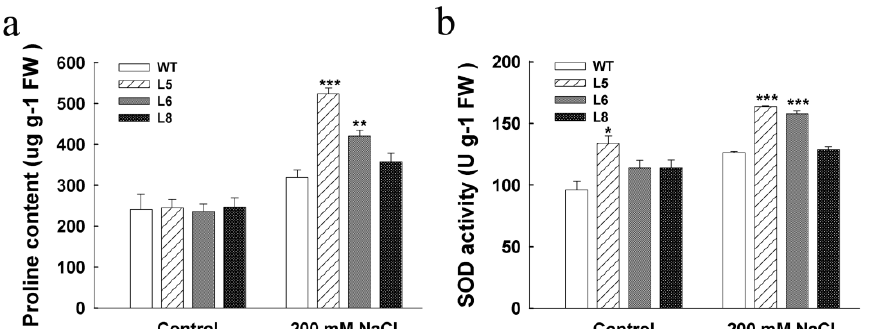
Figure 7. Physiological index analyses of LcSAIN3 -overexpressing plants. Proline contents ( a ) and antioxidant enzymes levels ( b ) in transgenic and WT seedlings exposed to 200 mM NaCl for 2 d. The bars indicate standard deviations, and the results are from three independent biological replicates. ***, **, and * indicate significant differences in comparison with the control at p < 0.001, p < 0.01, and p < 0.05, respectively.